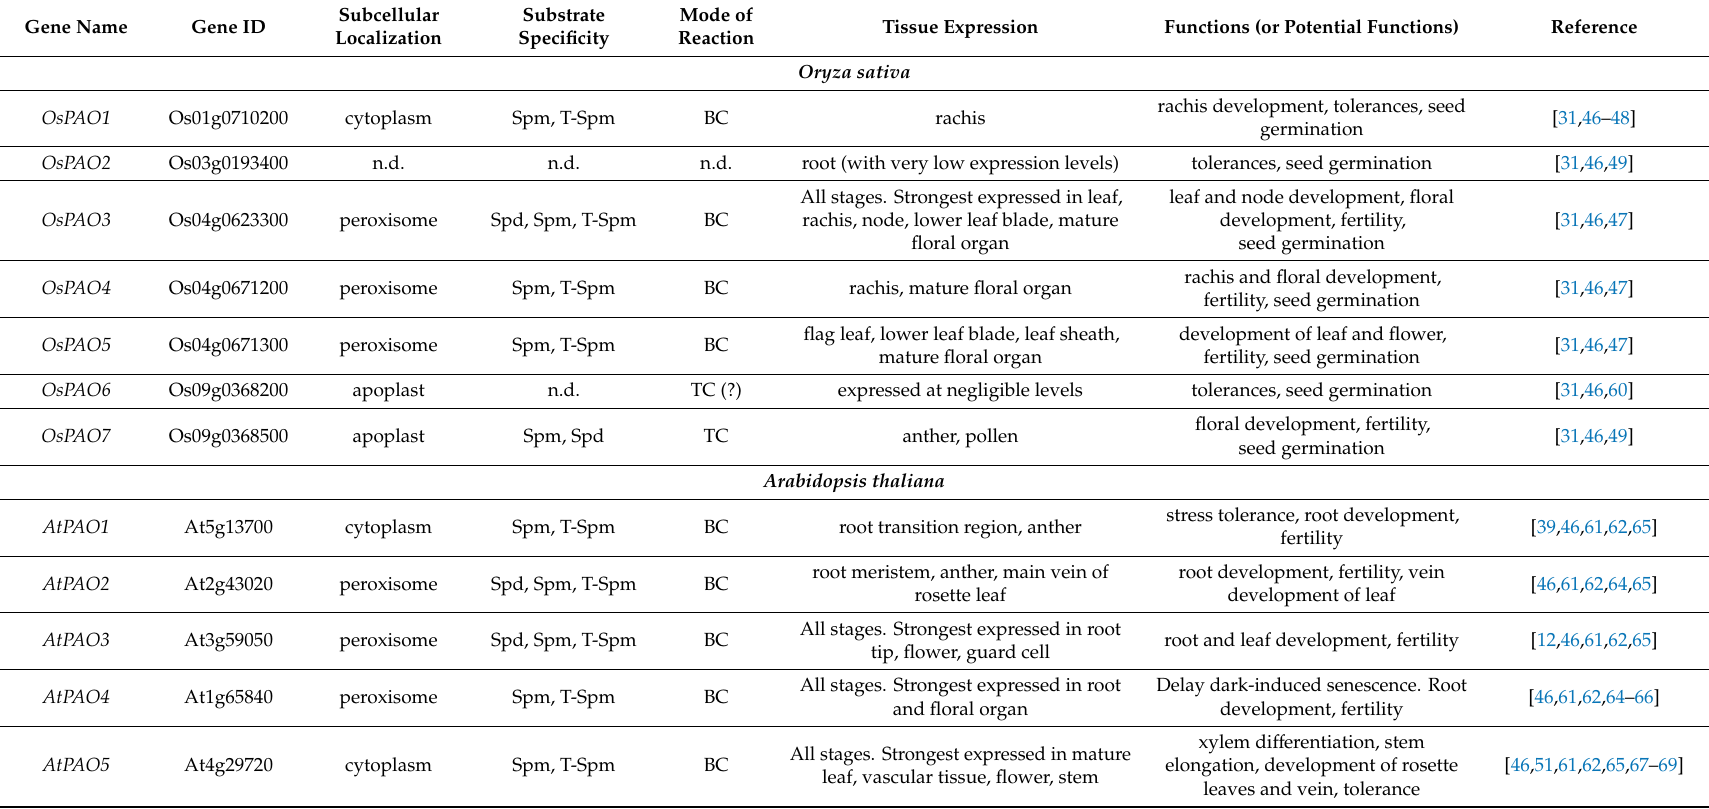
Table 2. Summary of PAOs in rice, Arabidopsis, and